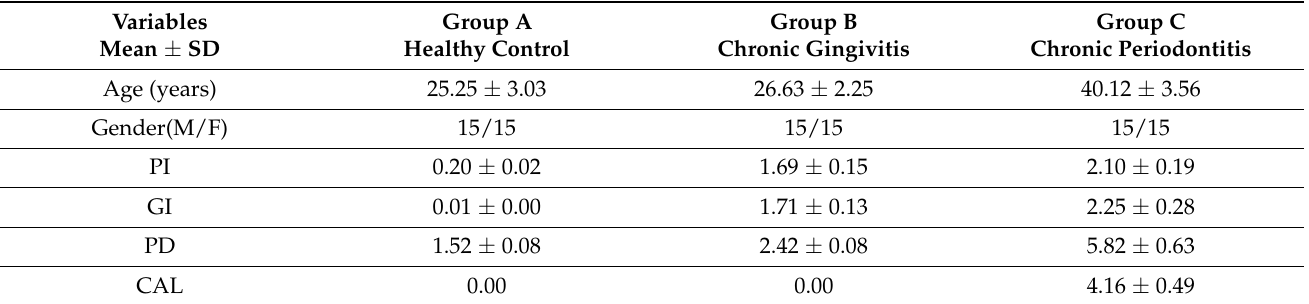
Table 1. Descriptive data of demographic and clinical parameters.